Question: From the figure, is the trend upward or downward?
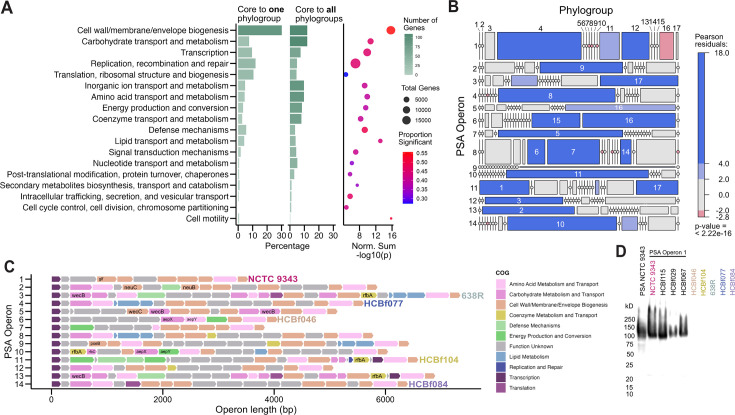
Answer: increasing